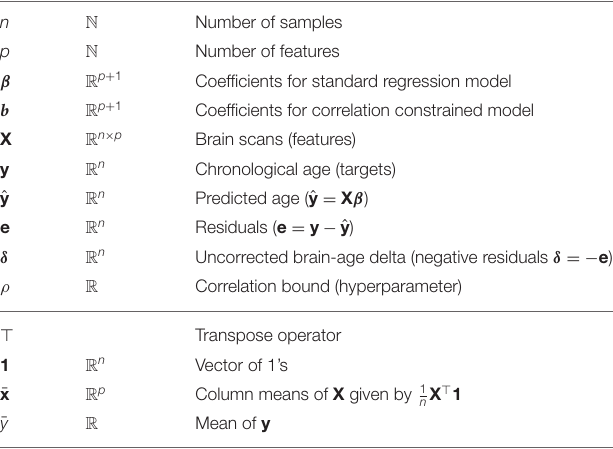
TABLE 1 | Mathematical notation, dimensionality, and description for the main quantities used in the regression